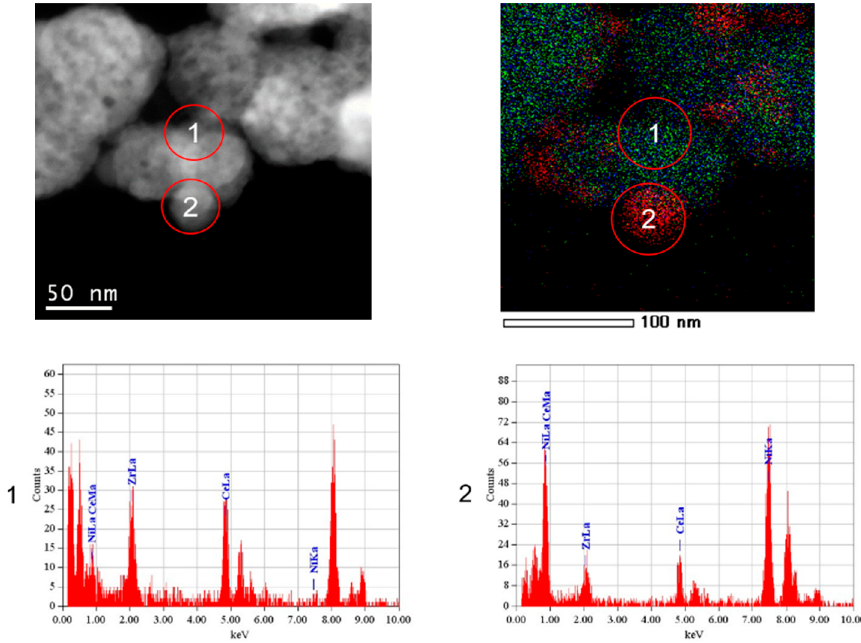
Figure 8. HAADF and STEM-EDX elemental mapping images of Ni-Ce 0.5 Zr 0.5 im: green—Zr, blue—Ce, and red—Ni.